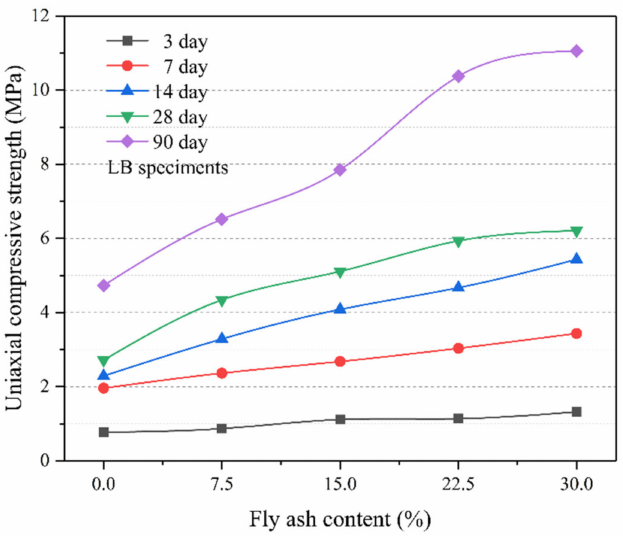
Figure 10. Influence of FA content and curing time on the uniaxial compressive strength of LB